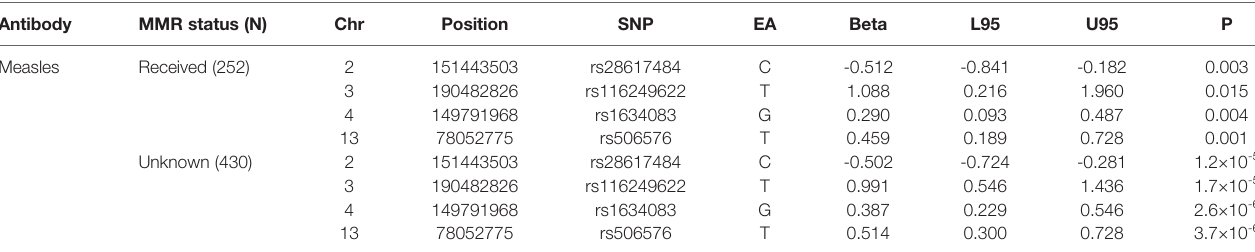
TABLE 4 | Strati fi ed analyses for antibodies against measles virus at the seven-year clinic by measles, mumps, and rubella (MMR) vaccine status.